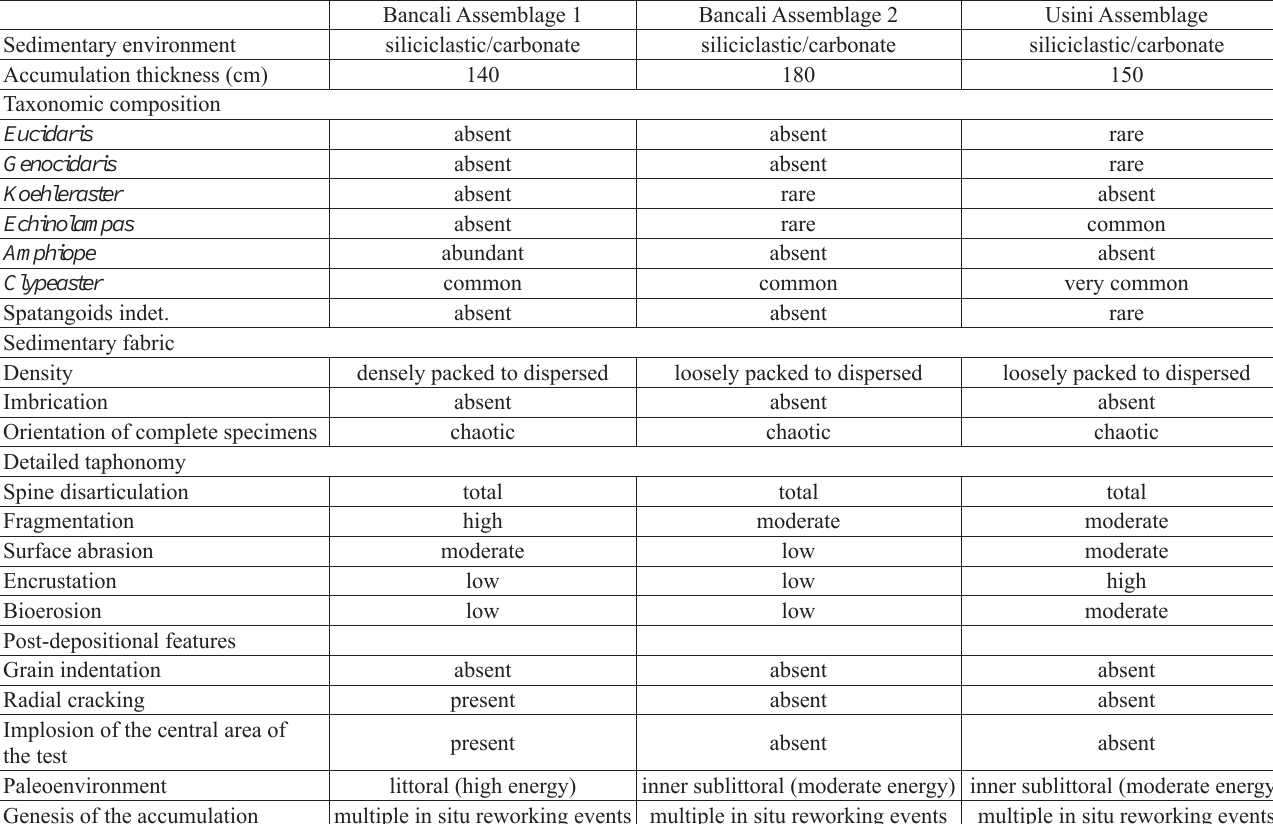
Table 2. Summary of taxonomic, sedimentological, and taphonomic features of the clypeasteroid assemblages from early Miocene sections at Bancali and Usini, Sardinia,